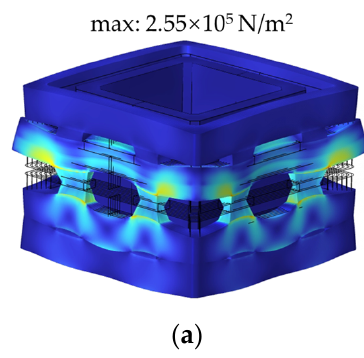
Figure 13. Stress distribution under middle-winding short circuit ( a ) Interleaved winding; ( b ) Continuous winding.